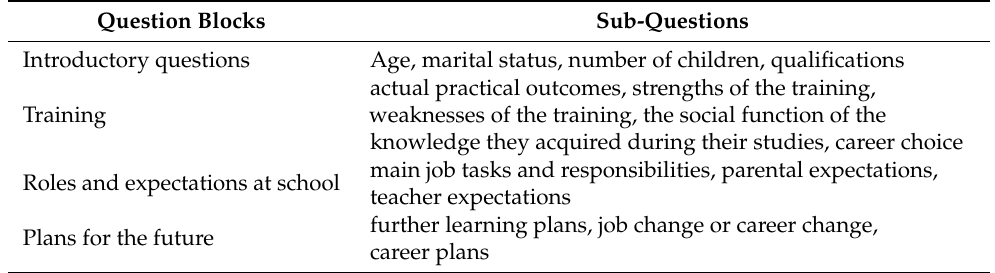
Table 3. Structure of the interview plan.